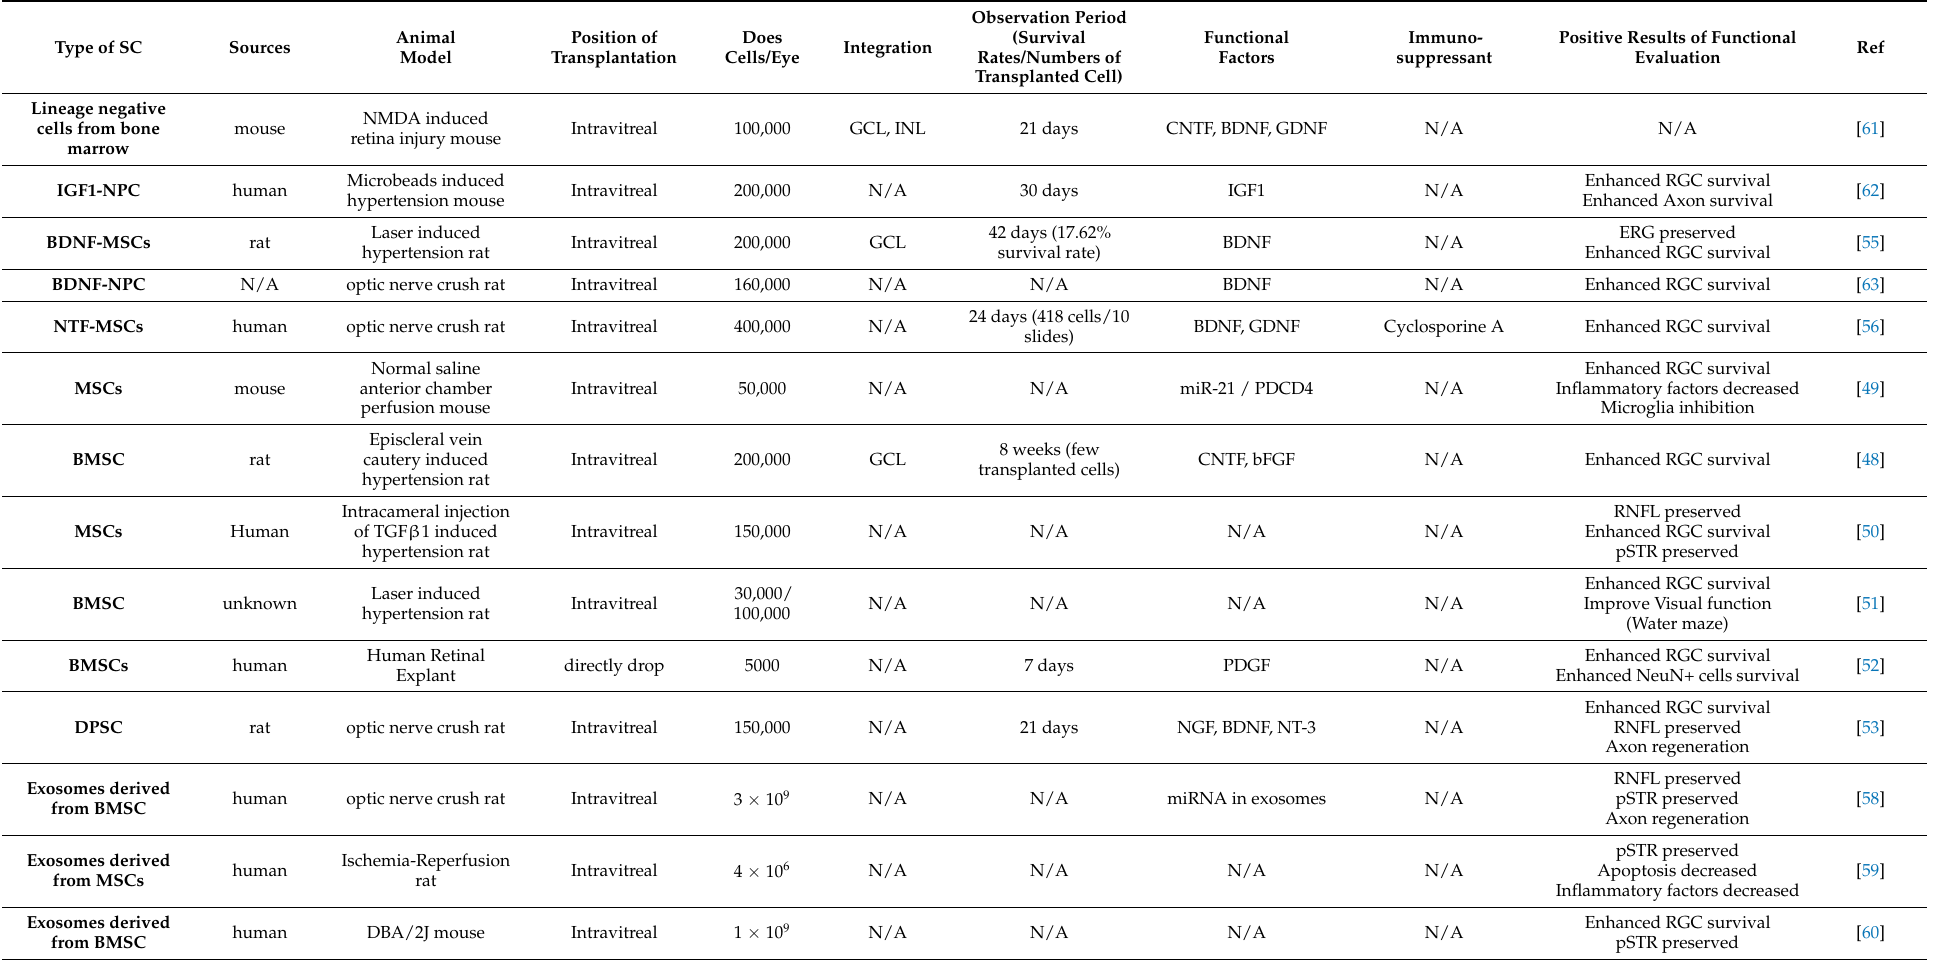
Table 2. Cell transplantation for RGC